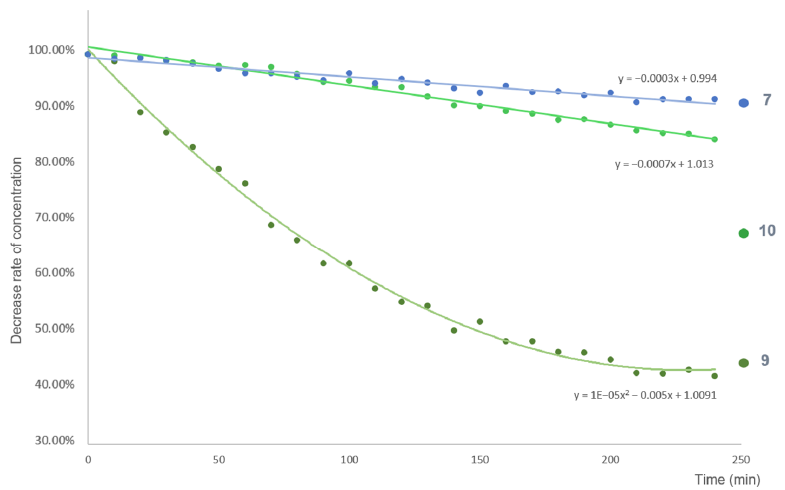
Figure 4. Degree of instability of compounds 7 , 9 , and 10 in aqueous solution. Each sample was dissolved in PBS (pH 7.4) at the concentration of 100 μM. The percentage of the decrease rate of the concentration at the UV absorption maxima of each compound was plotted as a function of time (lines were fitted using Microsoft Excel).